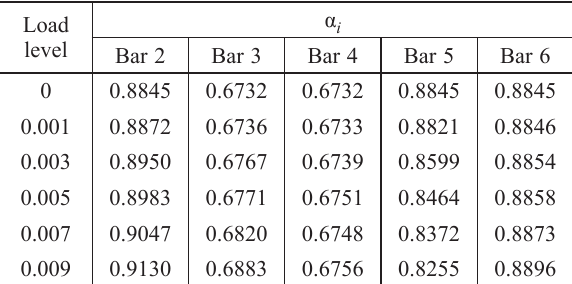
Table 6. Element importance indexes of the planar truss under horizontal load as shown in Figure 5(b)